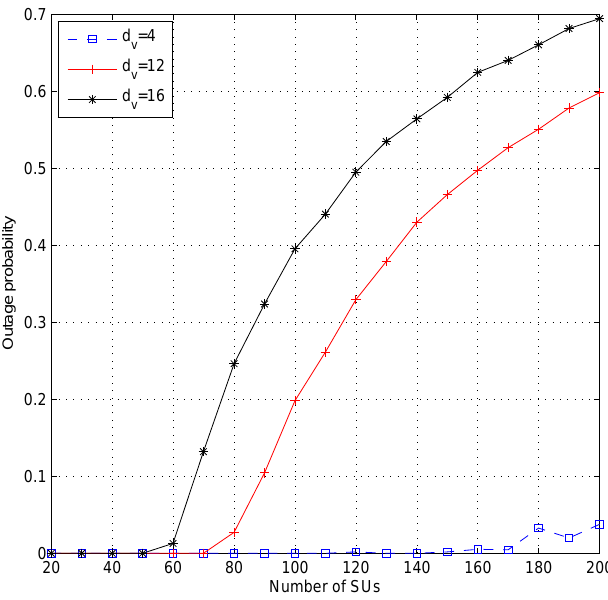
Figure 10. Outage probability of the proposed ILRA-FM Type 1 algorithm with the variation value of d v and fixed d c ( d c = 9).